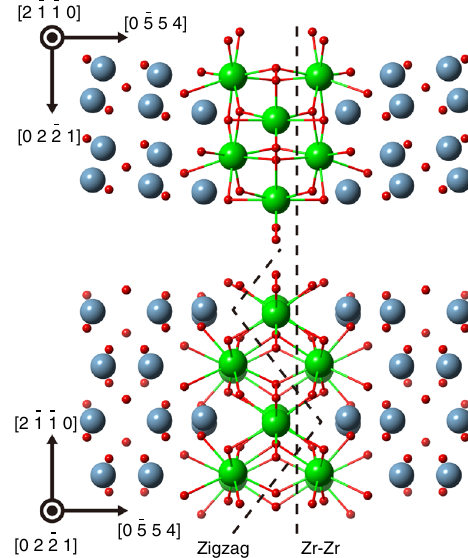
Fig. 4 Zr – O bonds cut along the zigzag fracture path and the Zr – Zr straight path. The structural model of the grain boundary viewed from two orthogonal directions with Zr – O bonds. In the initial structure, Zr atoms take oxygen atoms as eight-fold coordination. In both zigzag and Zr – Zr straight paths, Zr – O bonds broken in the fracture are equivalent and the same numbers, but the oxygen coordination numbers of Zr on fracture surfaces are different in both